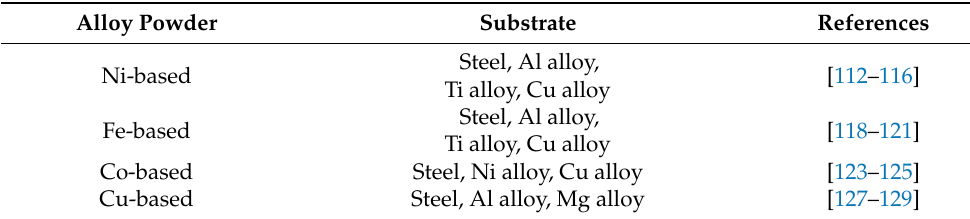
Table 2. Different self-fluxing alloy powders and corresponding substrates.